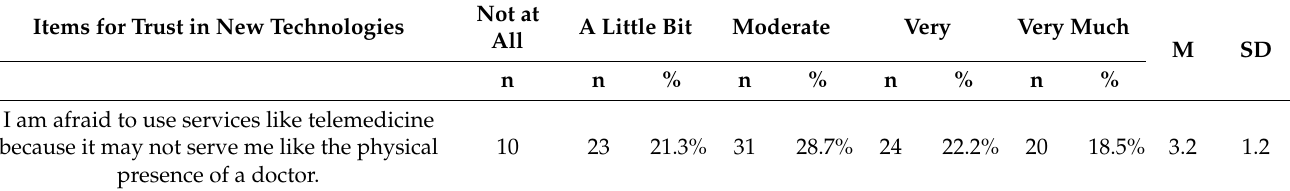
Table A6. Trust in new